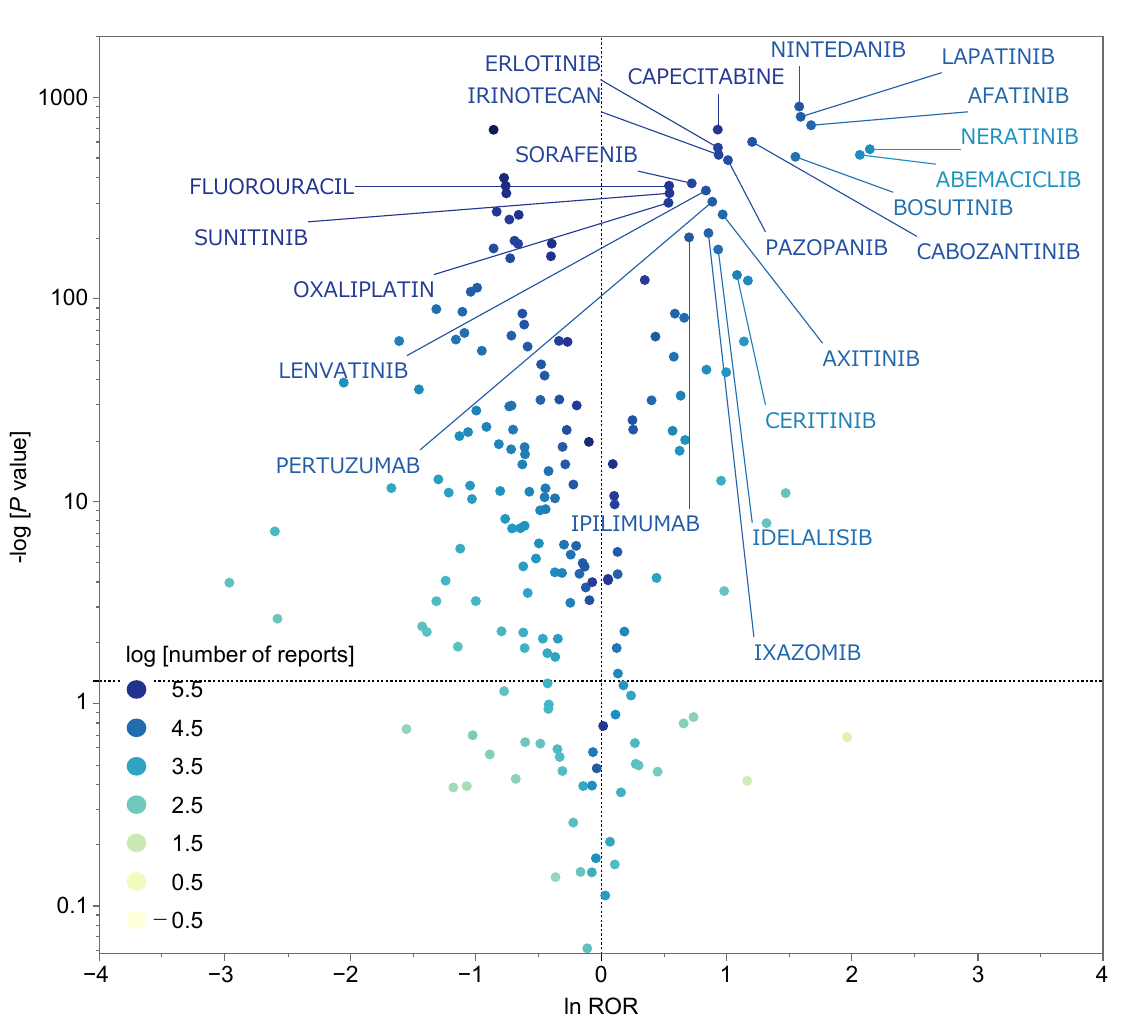
Figure 3. Drugs associated with the development of diarrhea. The x -axis shows the natural logaithms of the odds ratios (lnROR), and the y -axis shows the common logarithm of the inverse p -value ( − log10[ p -value]) from Fisher’s exact test. The ORs were calculated using cross-tabulation (Table 2). The dotted line on the y -axis represents p = 0.05. The plot colors show the common logarithm of the total number of reported adverse events for each drug. Table 2. Cross-tabulation and calculation formula for RORs of diarrhea. Diarrhea Reports with the Table 1. The drugs with highest RORs of diarrhea . Antineoplastic Number of p -Value Agents Report